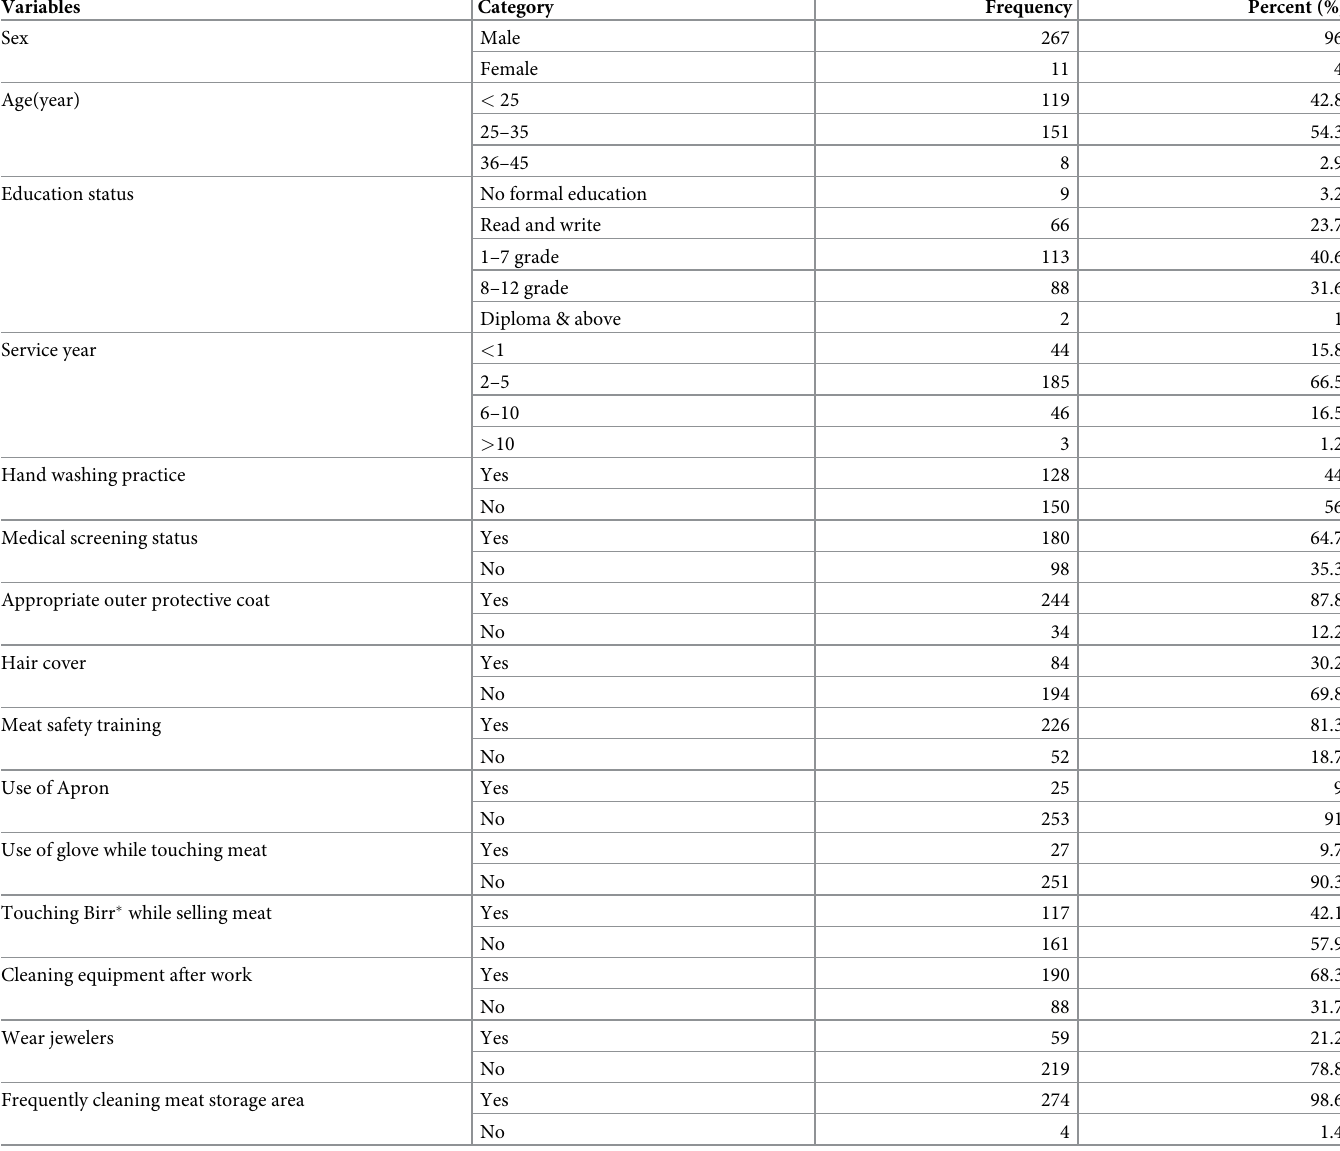
Table 1. Socio-demographic, sanitary and hygienic characteristics of meat handlers in butcher shops at Hawassa city, Sidama regional state, Ethiopia, 2020 (n = 278).